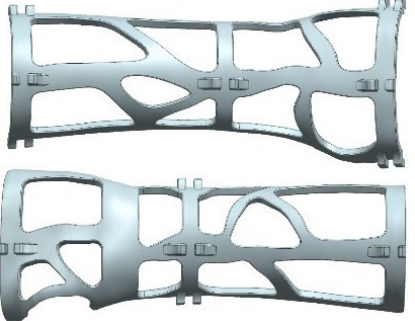
Figure 3. Example of a final model composed of two shells with ventilation holes and bend-ties housings .